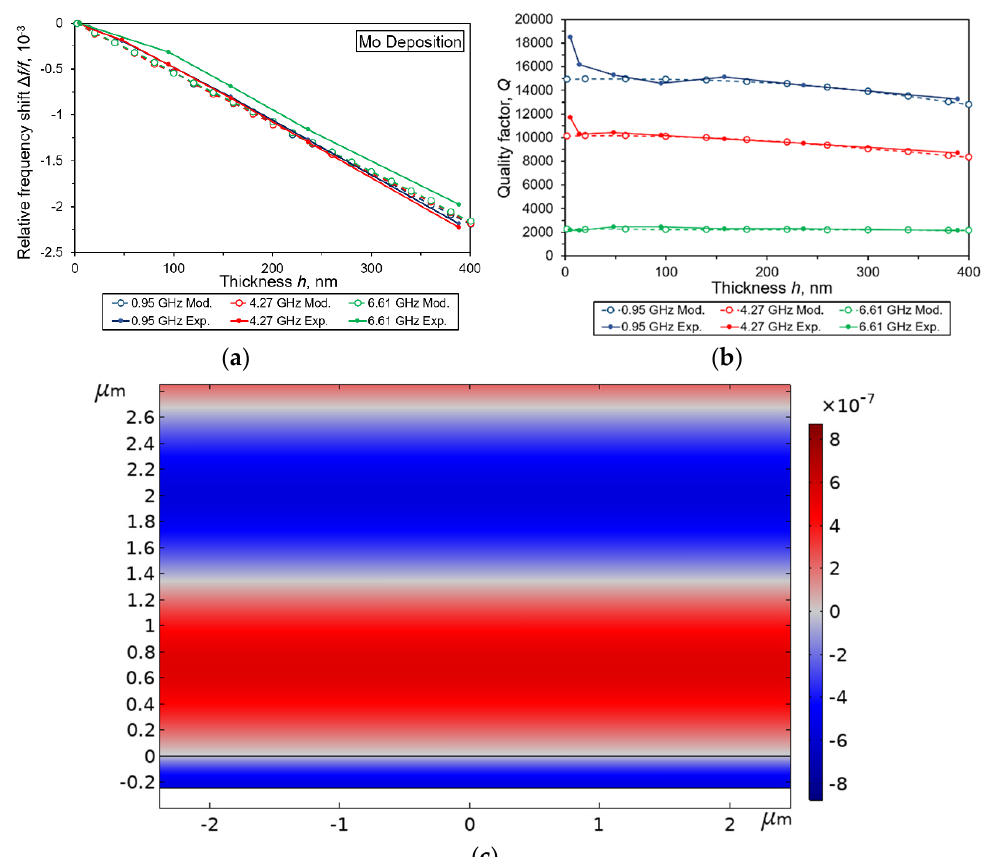
Figure 4. Relative frequency shift ( a ) and quality factor ( b ) vs. Mo film thickness measured for the microwave acoustic overtones taken at three operational frequencies of sensor #B. Model distribution of the L-BAW vertical Y-component of elastic displacements when h = 240 nm at 6.61 GHz ( c ).